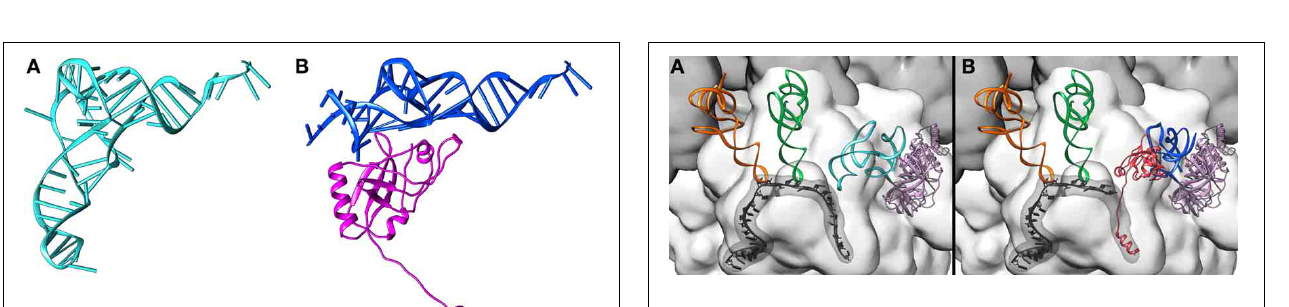
FIGURE 5 | Comparing ribosomal A-site recognition by canonical tRNA and tmRNA–SmpB. (A) tRNA pre-accommodated on the ribosome (Schmeing et al., 2009) (PDB entries 2WRN, 2WRO). The large 50S subunit is dark gray the, small 30S subunit is light gray, mRNA is black (the mRNA path is also highlighted), the E-site tRNA is orange, the P-site tRNA is green, EF-Tu is pink, and the incoming tRNA is light blue. (B) The TLD- SmpB complex pre-accomodated on the ribosome (Neubauer et al., 2012) (PDB entries 4ABR 4ABS). The C-terminal tail of SmpB folds into an α -helix inserted within the empty mRNA path. The color code is as (A) , with TLD in blue and SmpB in